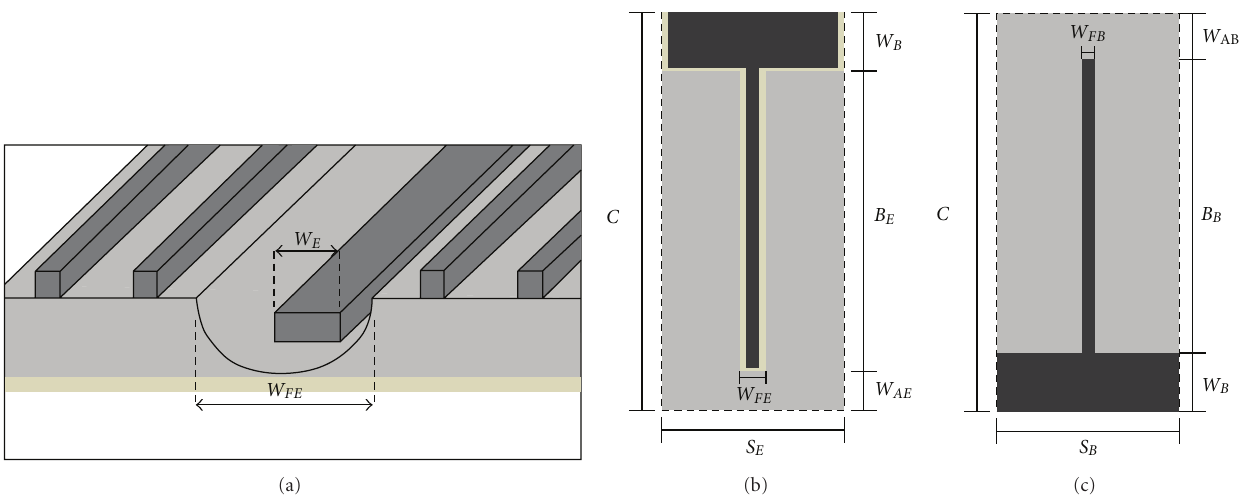
Figure 3: (a) Schematic representation of emitter groove and emitter finger (image is not to scale). (b) Sample emitter unit cell with labelling of each parameter. (c) Sample BSF unit cell labelling of each parameter.